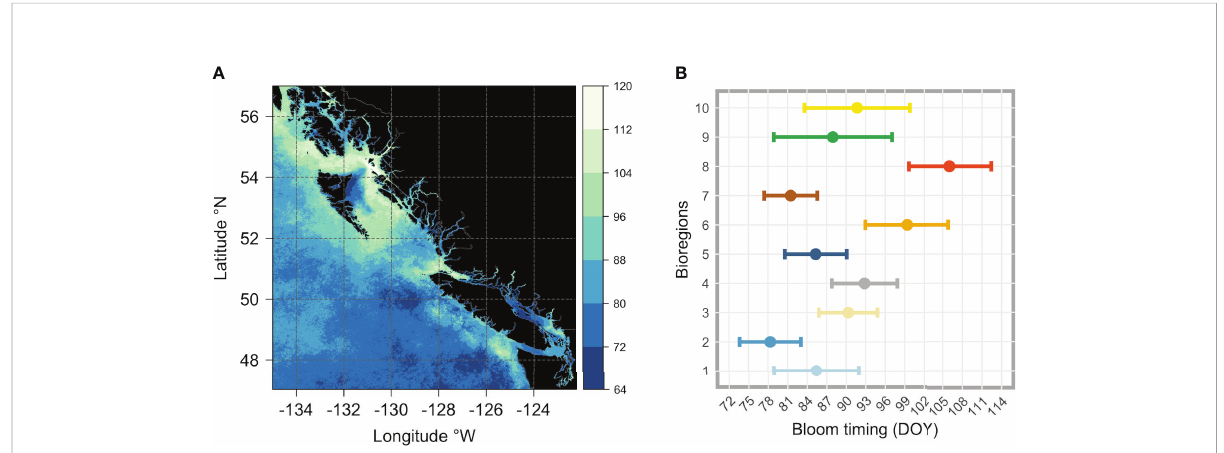
FIGURE 8 Figure showing (A) the climatological (2016-2020) spring bloom onset dates across the whole area of interest, and (B) for each bioregion (i.e., obtained averaging all pixels that are within each cluster). The vertical color bar in (A) indicates the day of the year (DOY), with colors ranging from dark blue (early bloom) to white (late bloom). In (B) , the colored dots (each color corresponds to that used in Figure 5 and identi fi es the same bioregion) represent the mean, and the horizontal bars represent the standard deviation (±